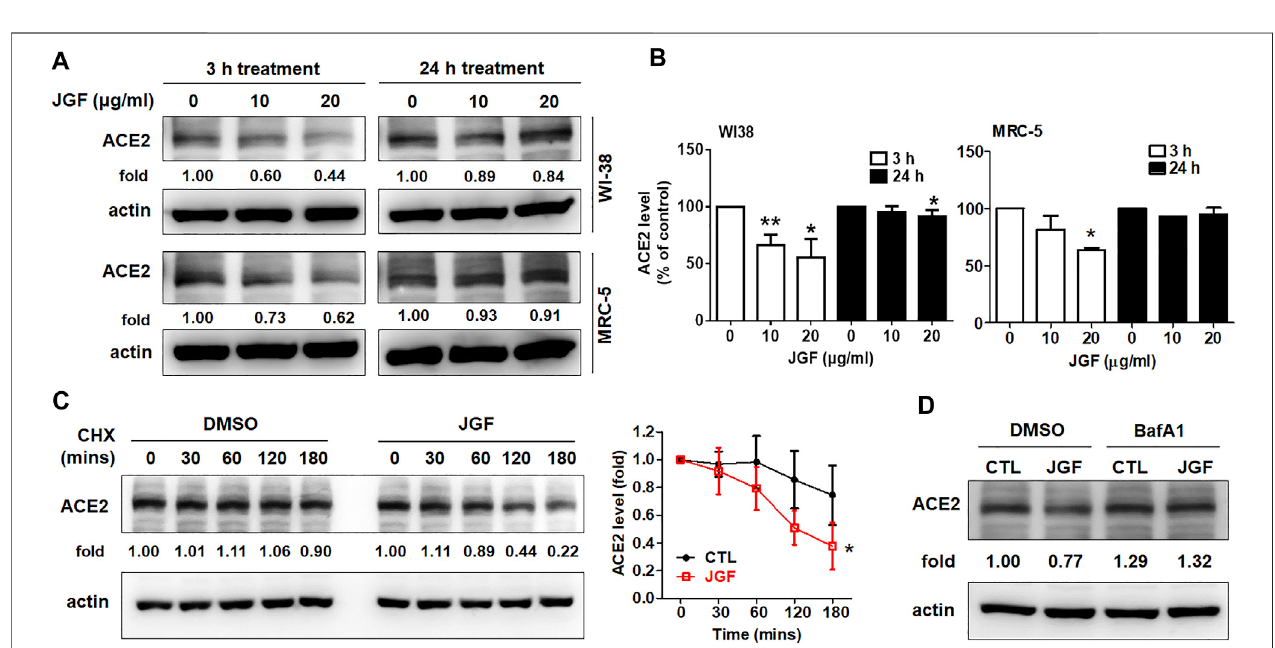
FIGURE 3 | JGF induces lysosome dependent degradation of ACE2. (A) WI-38 and MRC-5 cells were treated with three dosages of JGF (0 – 20 μ g/ml) for 3 and 24 h.Westernblottingwassubsequentlyperformedwithwholecelllysatestodetectexpression ofACE2. Actinwasusedastheinternalcontrol. (B) Quanti fi cationofthe intensities of the bands of ACE2 was representative of three separate determinations using ImageJ (National Institute of Mental Health, Bethesda, MD, United States). Thedatawerepresentedasthemean±SD;errorbarsindicatedSD.Signi fi cantdifferenceswereshown(* p < 0.05comparedtothecontrolgroup). (C) Timecourse for ACE2 degradation after the addition of cycloheximide (CHX; 100 μ g/ml) in the presence or absence of JGF (10 μ g/ml) for 0 – 180 min in WI-38 cells as analyzed by Western blotting. Right panel: The levels of ACE2 in the three-independent experiments were quanti fi ed by ImageJ and the results were presented as the mean ± SD; error bars indicate SDs. Signi fi cant differences were shown (* p < 0.05 compared to the control DMSO group). (D) WI-38 cells were pretreated with DMSO (vehicle control) or BafA1 (10 μ M) for 30 min, followed by incubation with JGF (10 μ g/ml) for 2